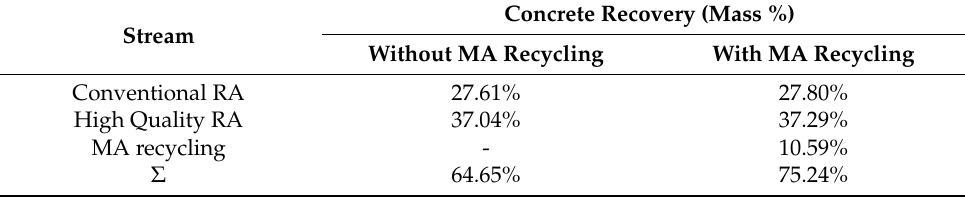
Table 7. Concrete distribution and